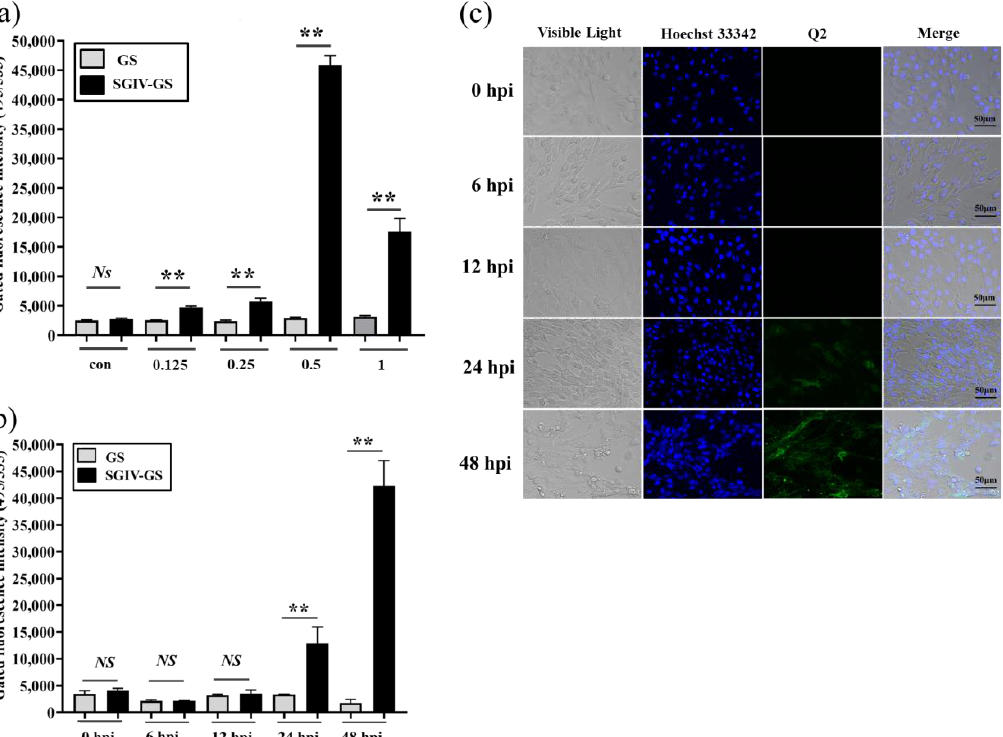
Figure 2 . Monitoring SGIV infection by FAM-Q2. ( a ) Monitoring different MOI of SGIV infection by FAM-Q2. ( b ) Monitoring SGIV (MOI = 0.5) with different infection time by FAM-Q2. Fluorescence on SGIV-infected cells could be detected at 24 hpi, and the fluorescence increased over time. Results are presented as mean ± SD of three independent experiments (** p < 0.01). ( c ) LSCM showed the specific binding of FAM-Q2 to SGIV-infected cells but not to normal GS cells.